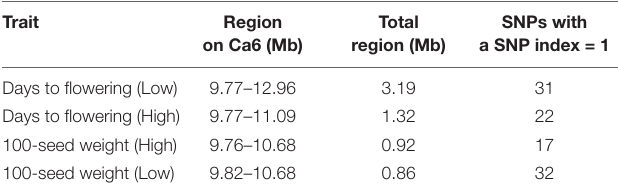
TABLE 3 | Summary of SNPs with SNP index 1 on chromosome Ca6.